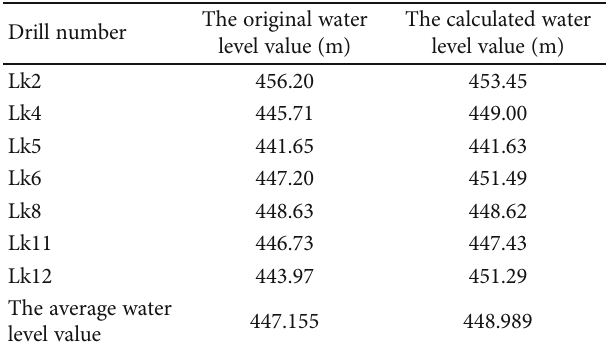
y -direction (in m 2 /s), and W is the source and sink term Table 2: The initial data and calculation results of the Fengfeng